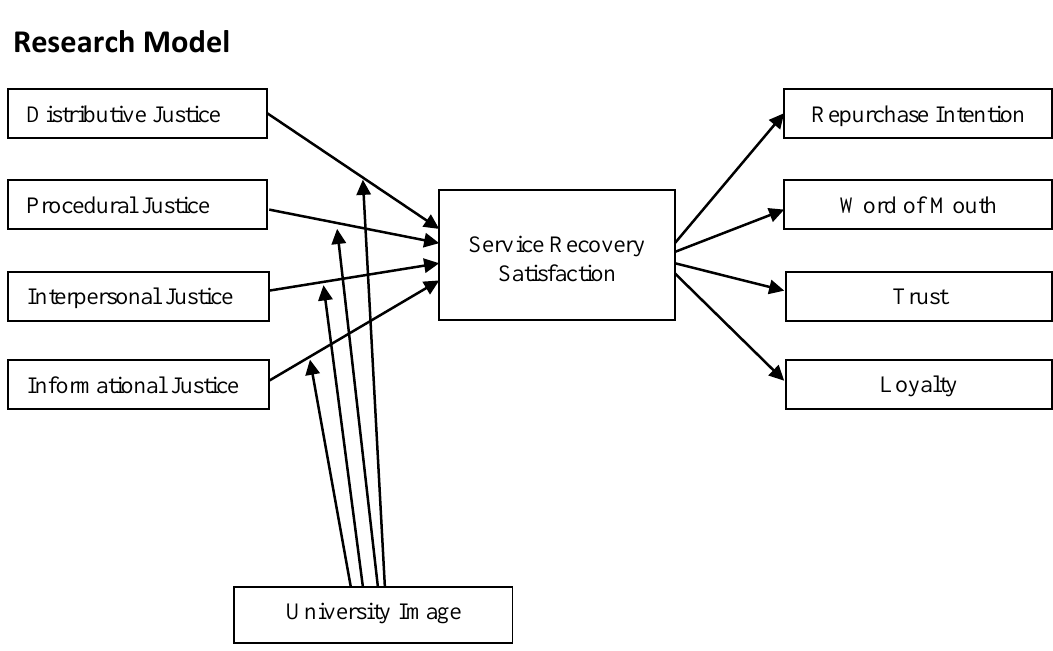
Figure 1 . Theoretical framework. Adapted from “Relationships of Perceived Justice to Service Recovery, Service Failure Attributions, Recovery Satisfaction, and Loyalty in the Context of Airline Travelers,” by D. Nikbin, M. Marimuthu, S. S. Hyun, and I. Ismail, 2015, Asia Pacific Journal of Tourism Research, 20(3) , p. 243 . CC